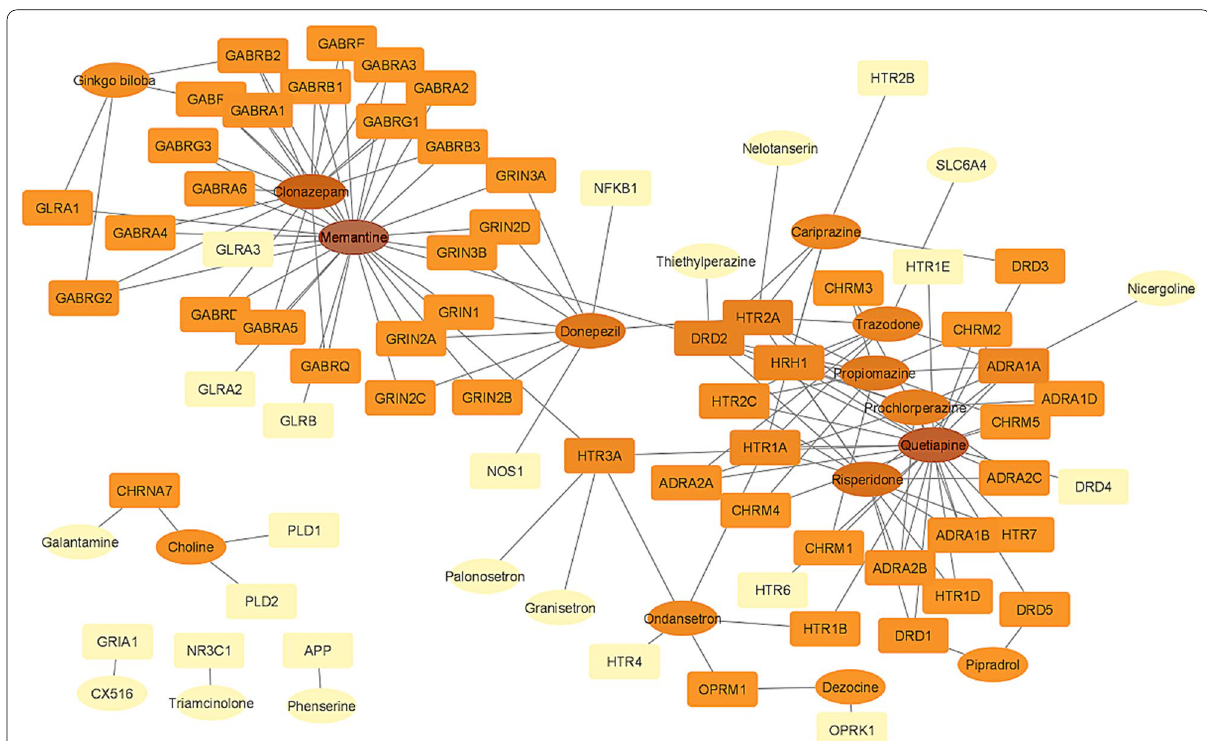
Fig. 2 Drug–gene interaction network visualized using Cytoscape. The nodes represent drugs and target genes and the edges represent drug– gene association. To differentiate between the two kinds of nodes, the drug nodes are shaped like an ellipse and the target gene nodes are shaped in a round rectangular fashion. The darker nodes are hub nodes that play an essential role in connecting node clusters in the network. Memantine (node degree 29, betweenness centrality 0.54) and quetiapine (node degree 26, betweenness centrality 0.39) form important hub nodes as = = = = they target GABAergic and acetylcholine receptors with donepezil as the bridge drug for the two